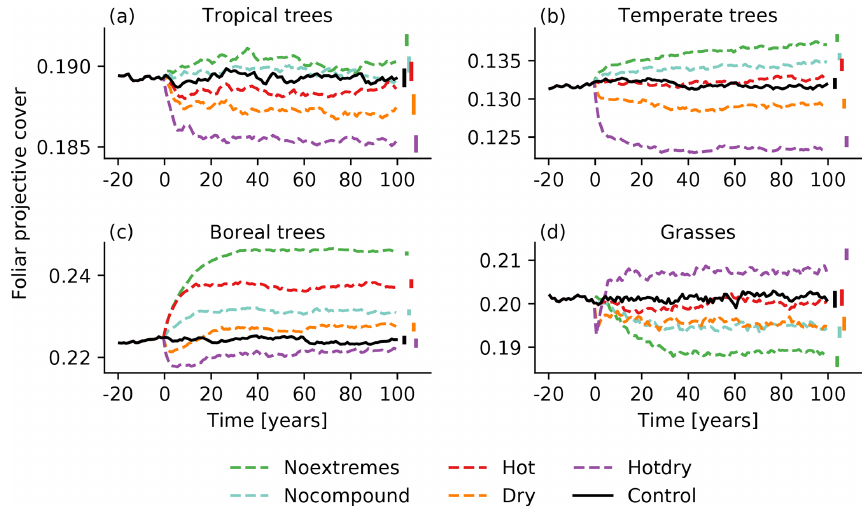
Figure 7. Time series of the fractional coverage (foliar projective cover) from the simulations that use the shared spin-up (black line). Scenarios are shown in dashed coloured lines for (a) tropical trees, (b) temperate trees, (c) boreal trees, and (d) grasses. The first 20 years ( − 20 to 0) represents the last 20 years of the shared spin-up. The variability (minimum to maximum) in vegetation cover in the individual-spin-up simulation (spin-up uses data from the respective scenarios) is indicated by the bars on the right-hand side. Note the different ranges of the y axes.